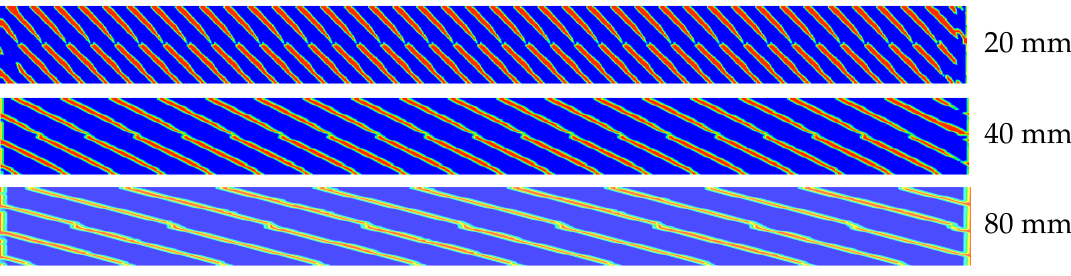
Figure 10. Simulation result for the e ff ects of ( a ) flow rate, Q , ( b ) screw pitch, and ( c ) equilibrium concentration on the concentration of volatile components in the extrudate.